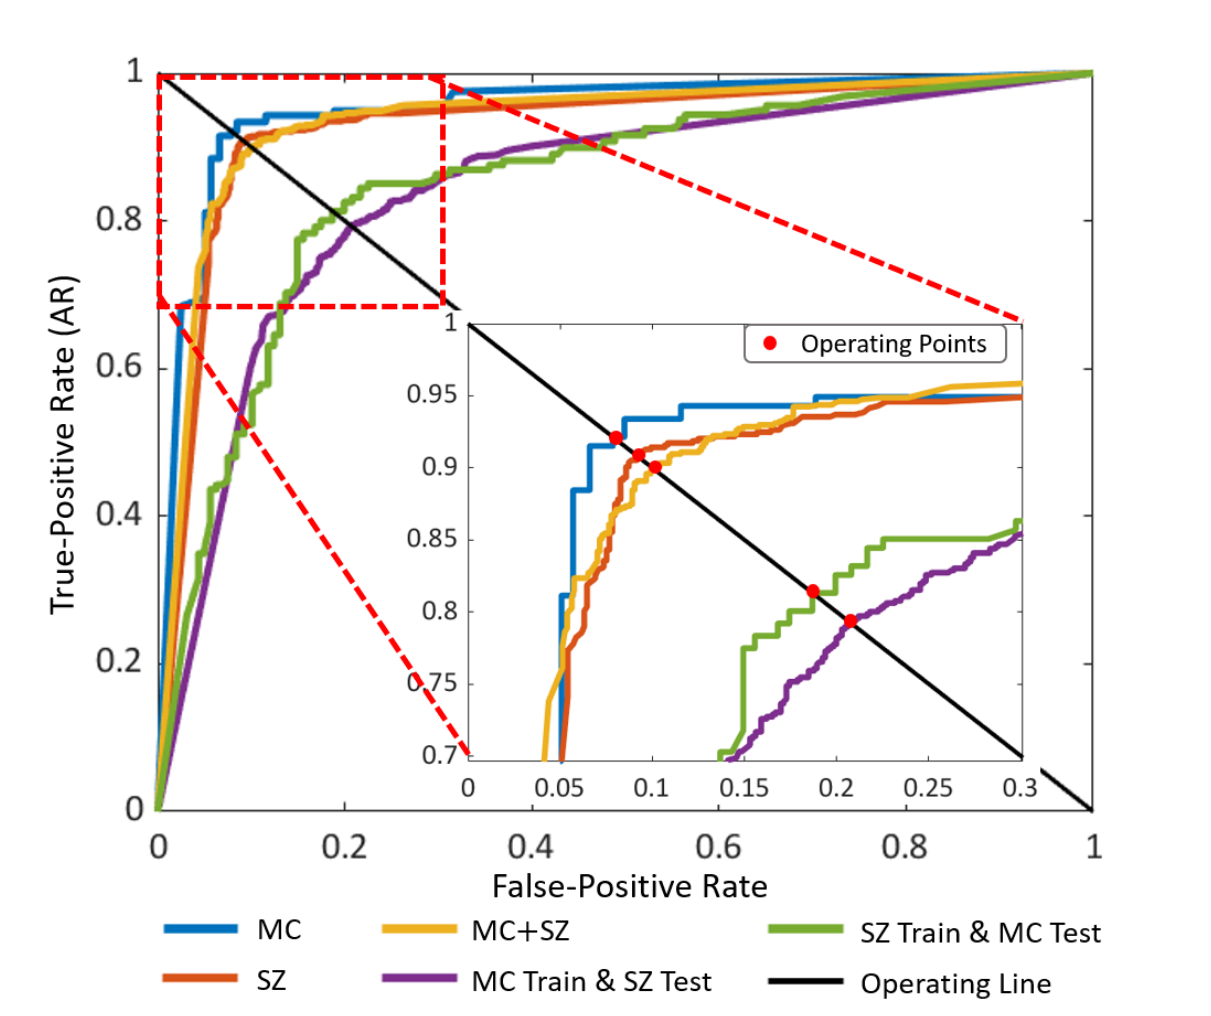
Figure 5. Receiver operating characteristic curves of our ensemble-SDCNN model for all the datasets. Each curve plots true-positive rate (TPR) vs false-positive rate (FPR) of our model at different classification thresholds beginning from 0 to 1 in 0.001 increments. MC: Montgomery County; SDCNN: shallow–deep convolutional neural network; SZ: